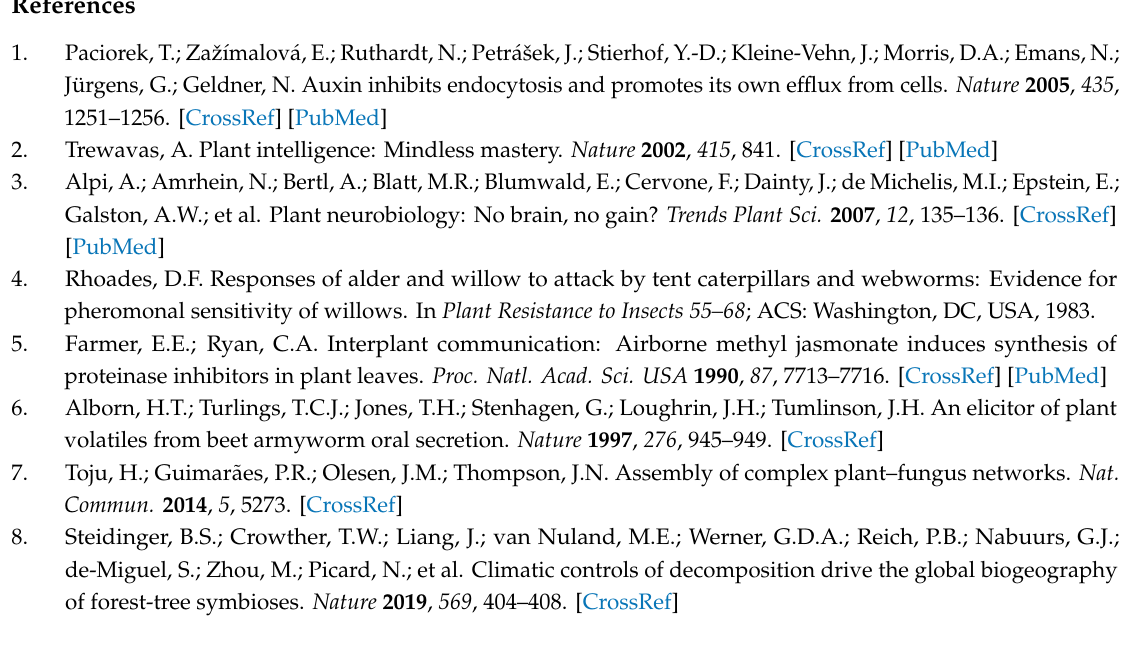
Figures S1, S2: Forest resection performed by trails, Figure S3: Data of severe crush spinal cord injuries (SCI) performed on mice. Data availability: Data